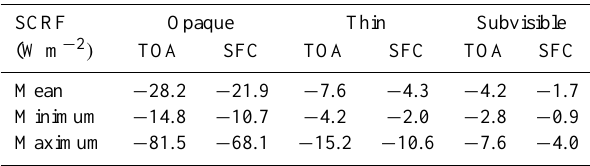
Table 2. Average, minimum and maximum values of the SCRF for the different cirrus types on the TOA y